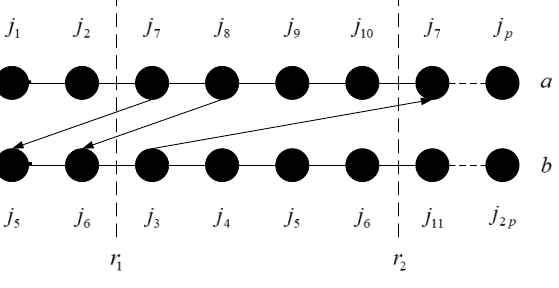
Figure 3. Mapping substitution process.